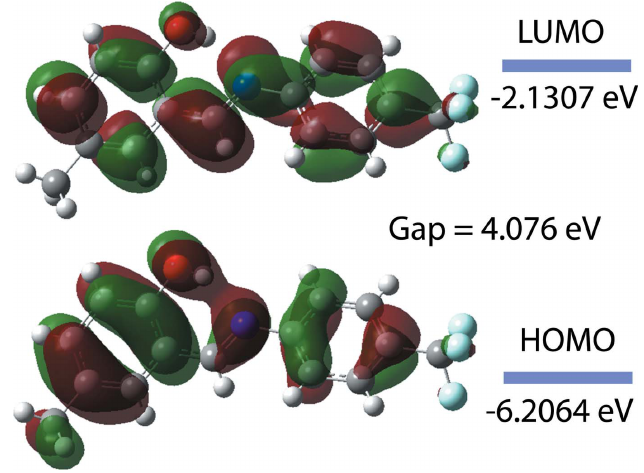
Figure 6 The energy band gap of